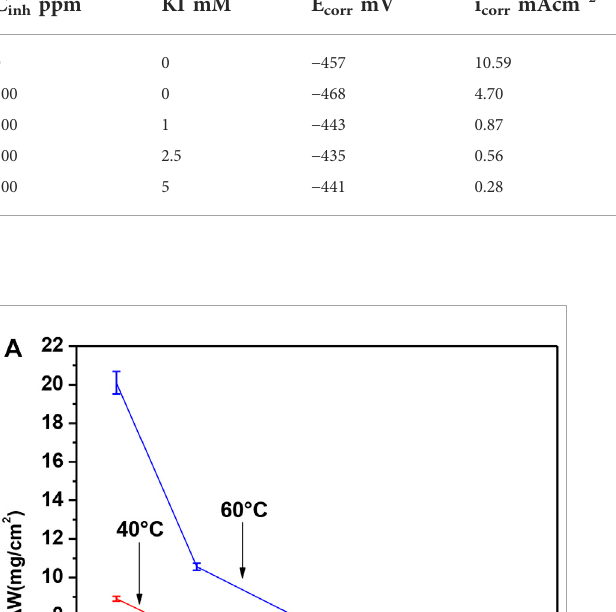
TABLE 5 Electrochemical parameters obtained from the polarization curves for corrosion inhibition of 1018 steel in acid media with 500 ppm of M. sativa and different KI concentrations at 60 ° C. C ppm inh